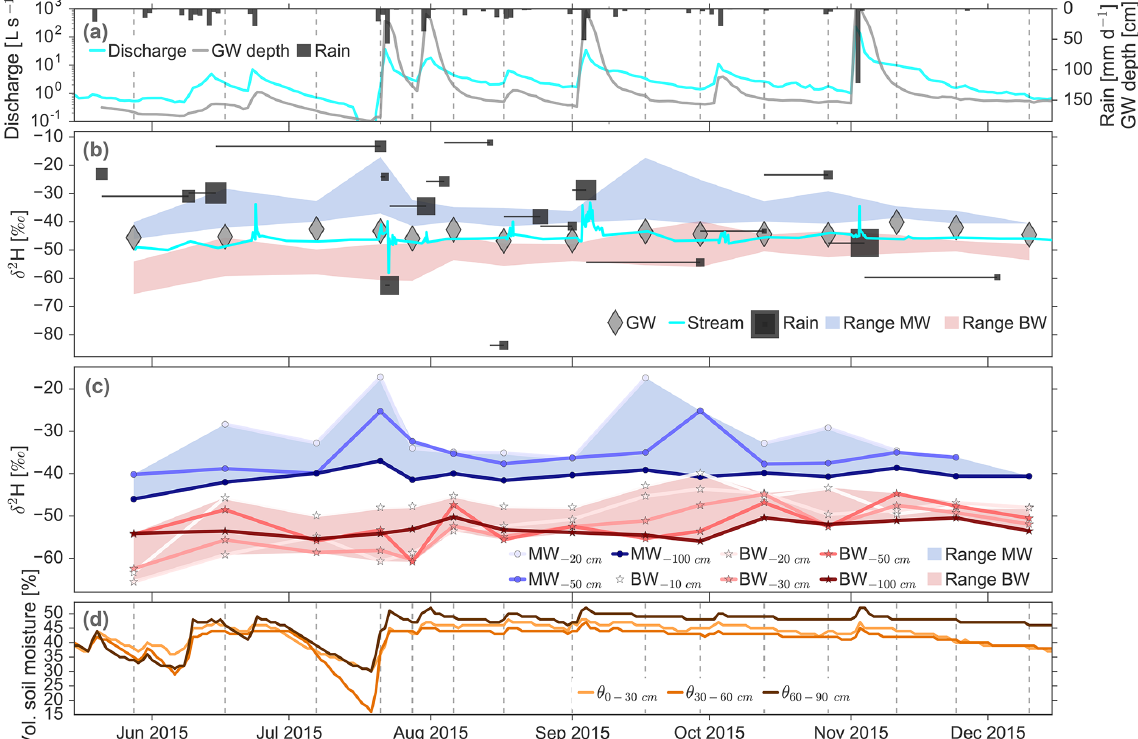
Figure 2. Temporal dynamics of hydrological conditions and stable isotopes during the soil water sampling period in 2015. (a) Catchment runoff at outlet (cyan), groundwater (GW) depth (grey) and daily rainfall volumes (black) at the study site. Note the logarithmic scale for discharge. (b) Stable isotope composition ( δ 2 H) of stream water, groundwater, and rainfall. Blue and red shaded areas show the range of mobile water (MW) and bulk soil water (BW). Note that the size of the black squares indicates the rainfall amount, and the black lines represent the time span over which rainwater was cumulatively sampled. (c) Stable isotope composition of mobile water and bulk soil water at different depths. (d) Volumetric soil moisture at three depth